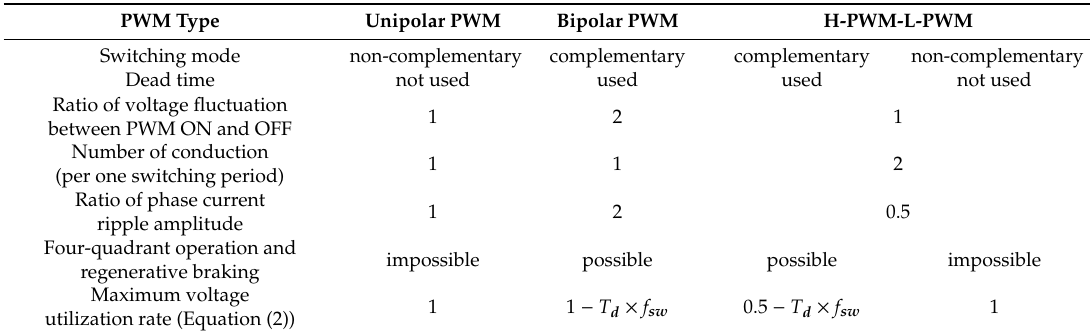
Table 1. Electrical and operation characteristics of various PWM methods for BLDC